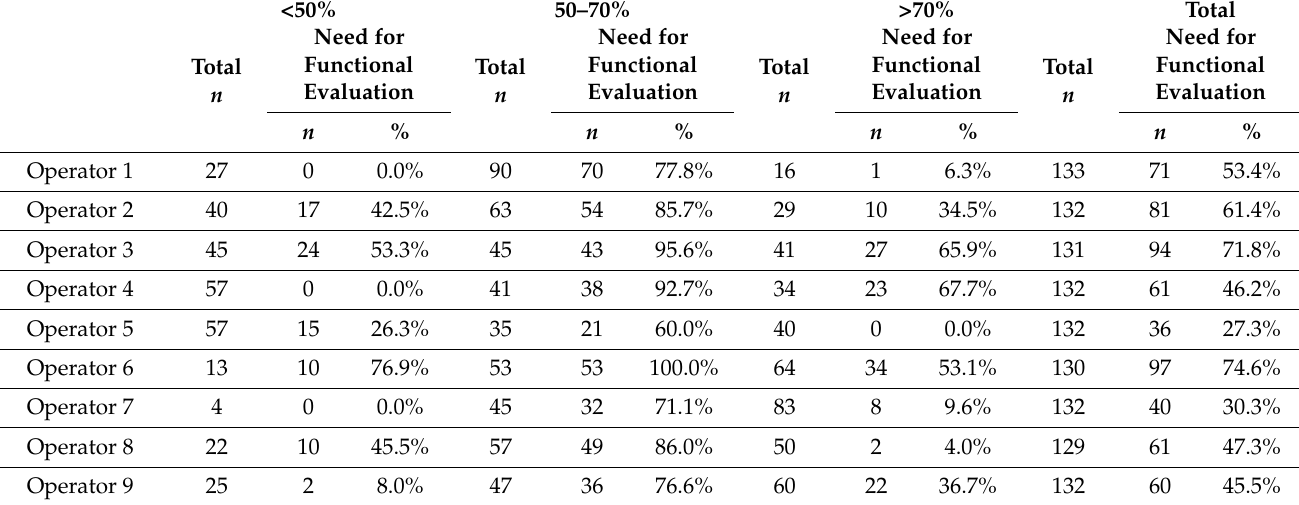
Table A4. Need for functional evaluation for each operator based on stenosis severity (as graded by each